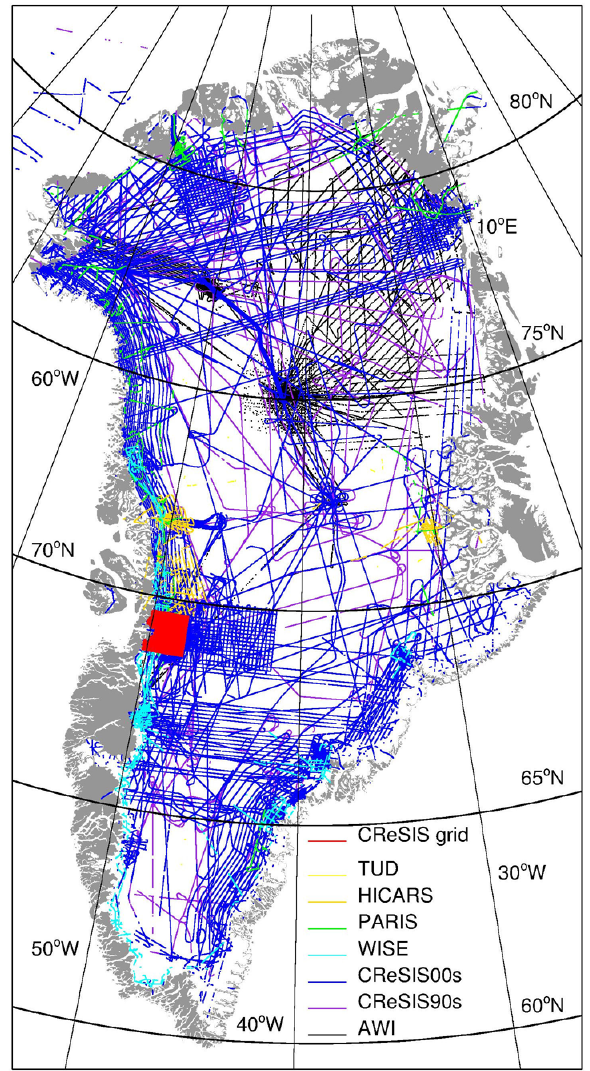
Fig. 1. Data sources. CReSIS90 (purple) includes all data from 1993 to 1999 as used in (Bamber et al., 2001b). CReSIS00 (blue) includes all data derived from CReSIS instruments between 2000 and